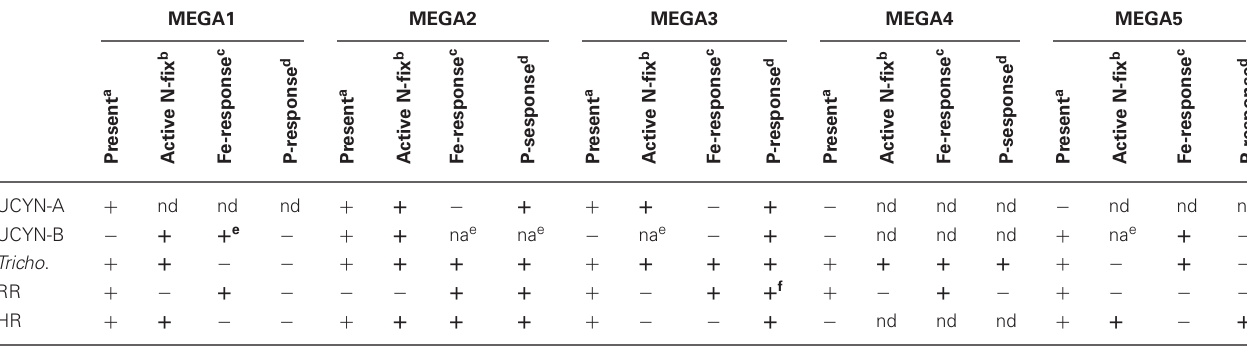
Table 4 | Synthesis of MEGA experimental results, indicating the nutrient stress conditions that can be